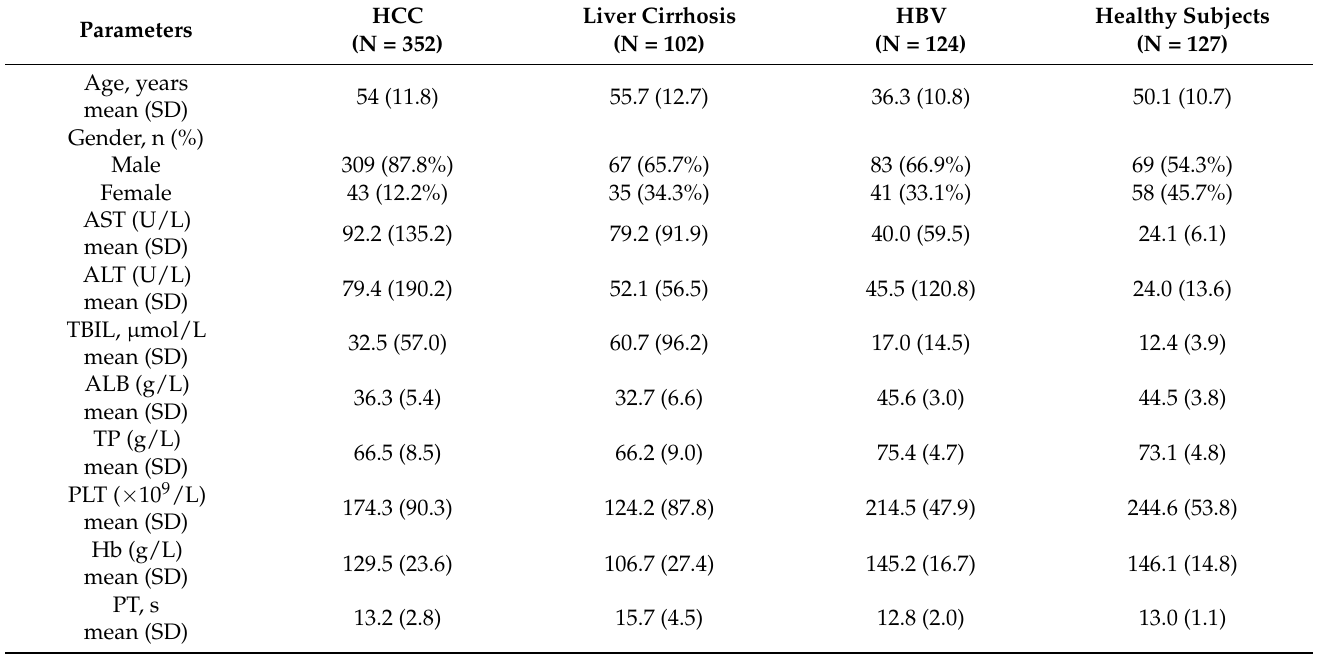
Table 1. Clinical characteristics of the study